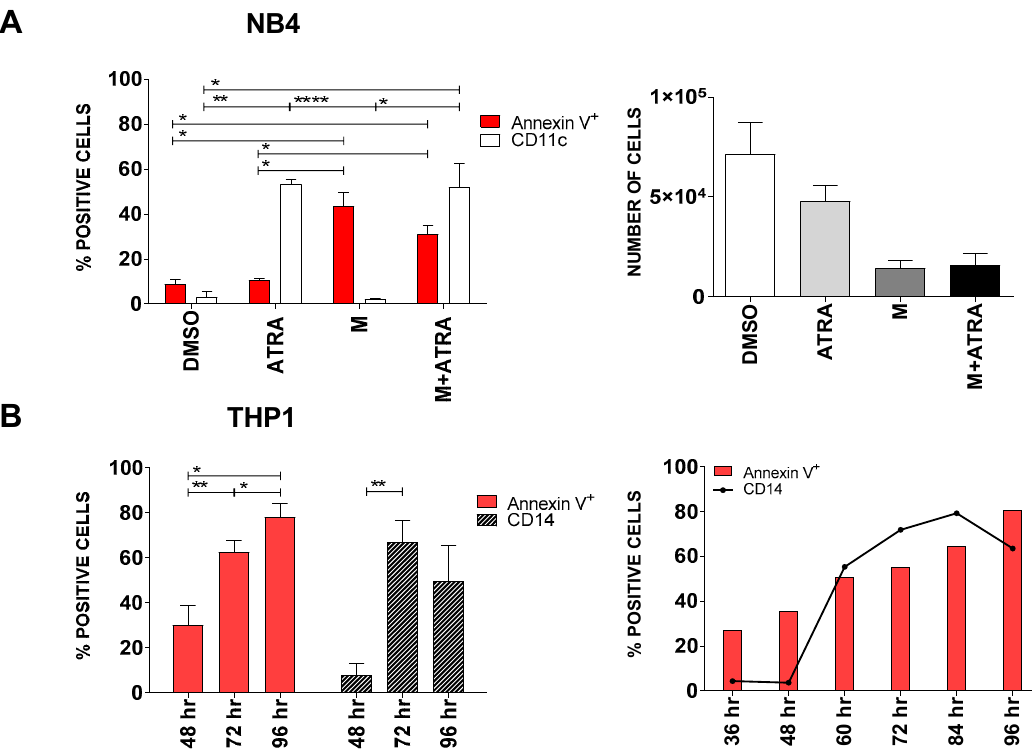
Figure 4. MEDS433 can induce apoptosis and differentiation separately. ( A ) Left panel: apoptotic and differentiating rate of NB4 cells treated with ATRA, MEDS433 or both ( n = 3). Right panel: viable NB4 cells after treatment with ATRA, MEDS433 or both ( n = 3). ( B ) Kinetic of apoptosis and differentiation of THP1 cells treated with MEDS433. In all experiments, MEDS433 was utilized at 1 µM and ATRA at 0.1 µM. Differentiation of NB4 cells was best evaluated with CD11c expression, while THP1 cells with CD14 expression. The analyses shown in panel A were performed after 3 days of treatment. DMSO: dimethyl sulfoxide. ATRA: all-trans retinoic acid. M: MEDS433. hr: hours. ( A ) Statistical significance: Anova/Tukey, * p < 0.05; ** p < 0.01; *** p < 0.001; **** p < 0.0001. ( B ) Statistical significance: t -test, * p < 0.05; ** p < 0.01.